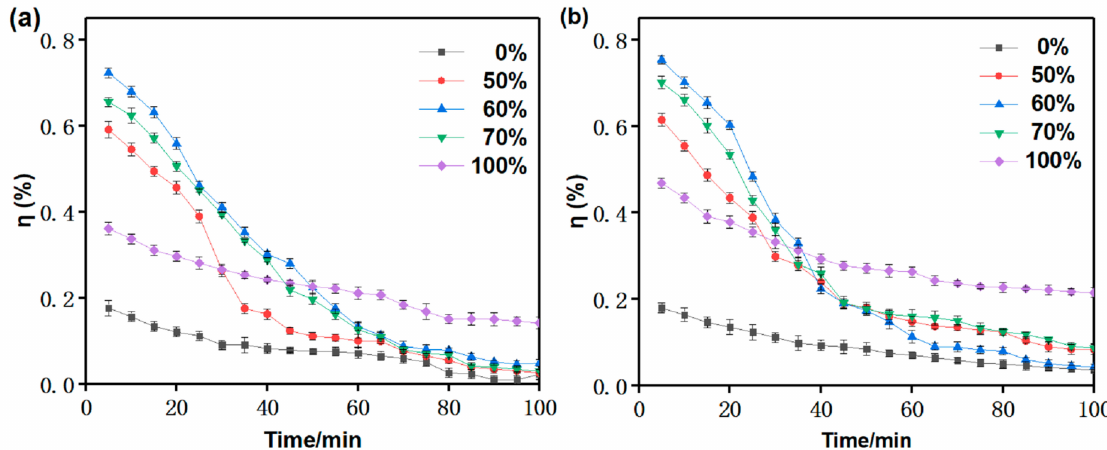
Figure 2. The influence of mass fraction of IL in complex absorbent on the absorptivity for ( a ) DCM and ( b ) benzene